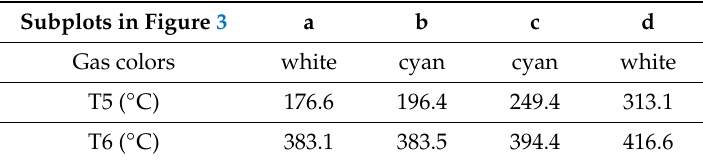
Figure 3. Color changes of jet gas of C6 between 1107 s and 1132 s. Table 1. Pole temperatures of C6 in Figure 3.